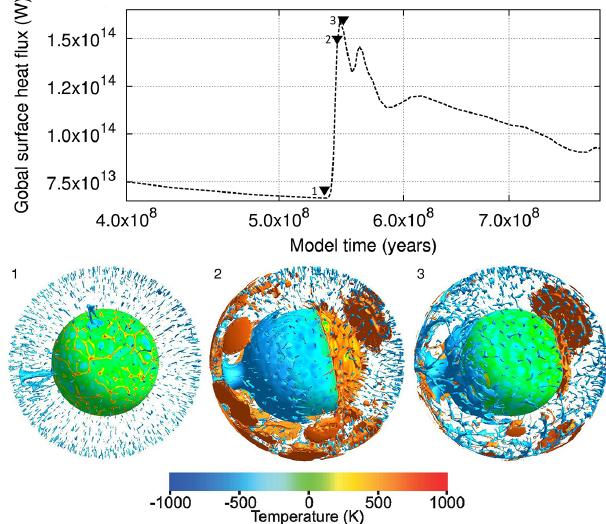
Figure 3. Visualization of Case 2. The graph (top) is an enlargement from Fig. 1; the numbered triangles indicate the time of the panels below. (1) The avalanche initiates; material from the upper man- tle begins to enter the lower mantle where it shows up as anoma- lously cold. (2) Avalanche in full flow; antipodal plumes have al- ready reached the surface. (3) The avalanche has now progressed to “pulling” hot material from the antipodal plume towards itself. Iso- surfaces follow − 500 and + 700K anomalies; the uppermost 5% of the isosurfaces are clipped to improve clarity of the deep